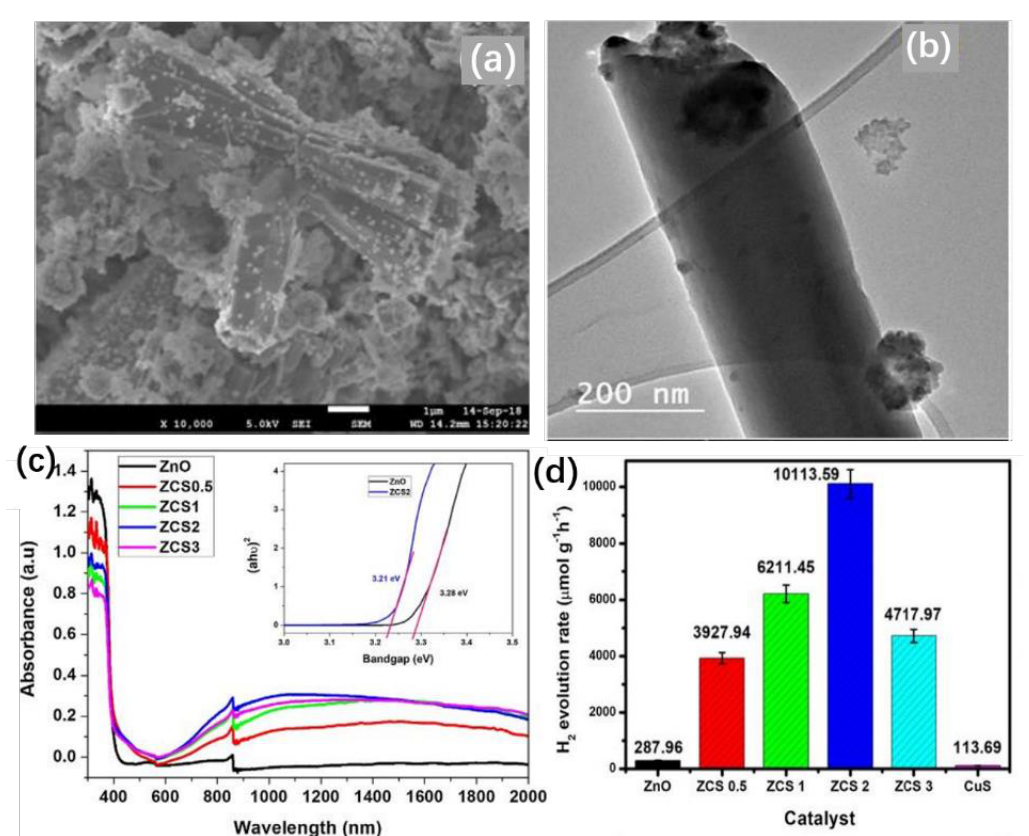
Figure 2. ( a ) Field emission scanning electron microscopy (FESEM) image of ZnO@CuS (2%) nanocomposite. ( b ) TEM image of ZnO@CuS (2%) nanorods. ( c ) Ultraviolet (UV) – visible (vis) diffuse reflectance spectra of pristine ZnO and ZnO/CuS nanocomposite. The inset shows the Tauc plots for ZnO and ZCS2. ( d ) Comparison of photocatalytic H 2 production rates of all the samples. Copy- right © 2021 Elsevier B.V.